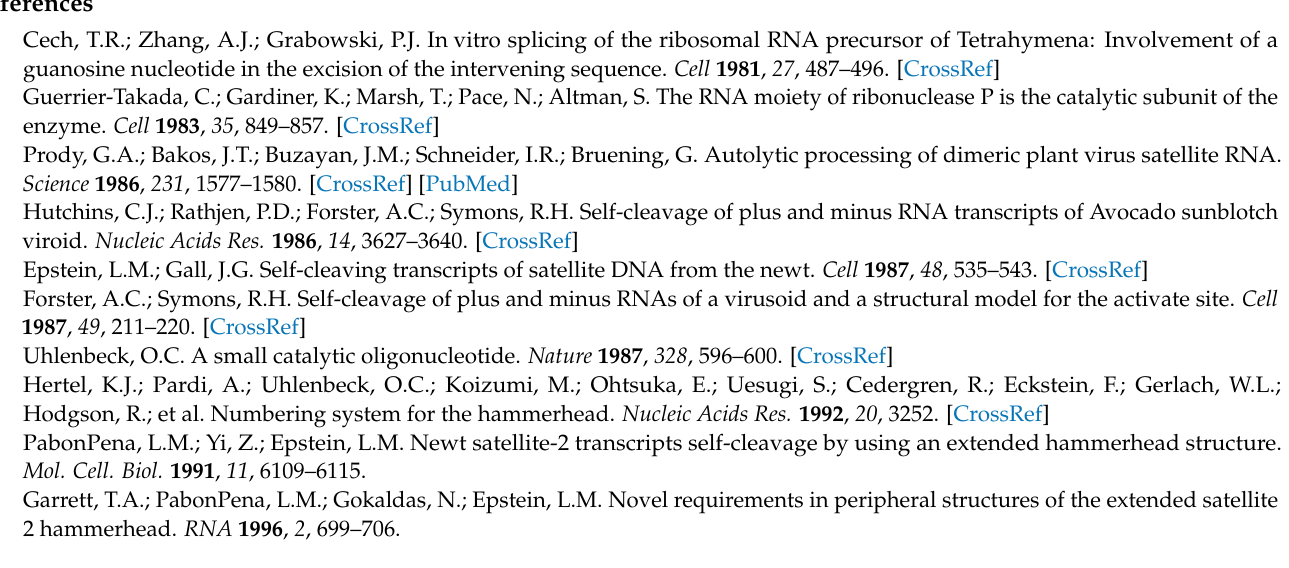
RNA duplex, Figure S2: The 1 H- 1 H NOESY spectrum of the RNA duplex 1 at pH 8.18 in the absence of CdCl 2 . Figure S3: The natural abundance 1 H- 13 C HSQC of the RNA duplex 1 at pH 8.18 in the absence of CdCl 2 . Figure S4: The 1D 1 H NMR spectra of duplex 2 under pH 10.9, 10.4 and 10.9. Figure S5: The natural abundance 1 H- 13 C HSQC of the RNA duplex 1 at pH 4.4. Table S1: Chemical shielding calculated for H8 atom in G in ppm, Table S2: Chemical shielding calculated for H8 atom in G in